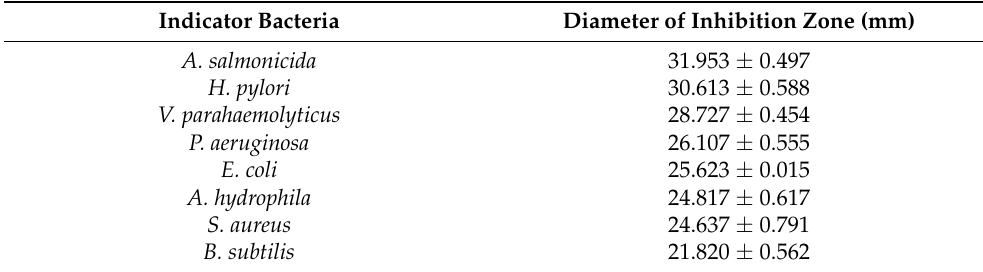
Table 1. Antibacterial spectrum of EPS of strain